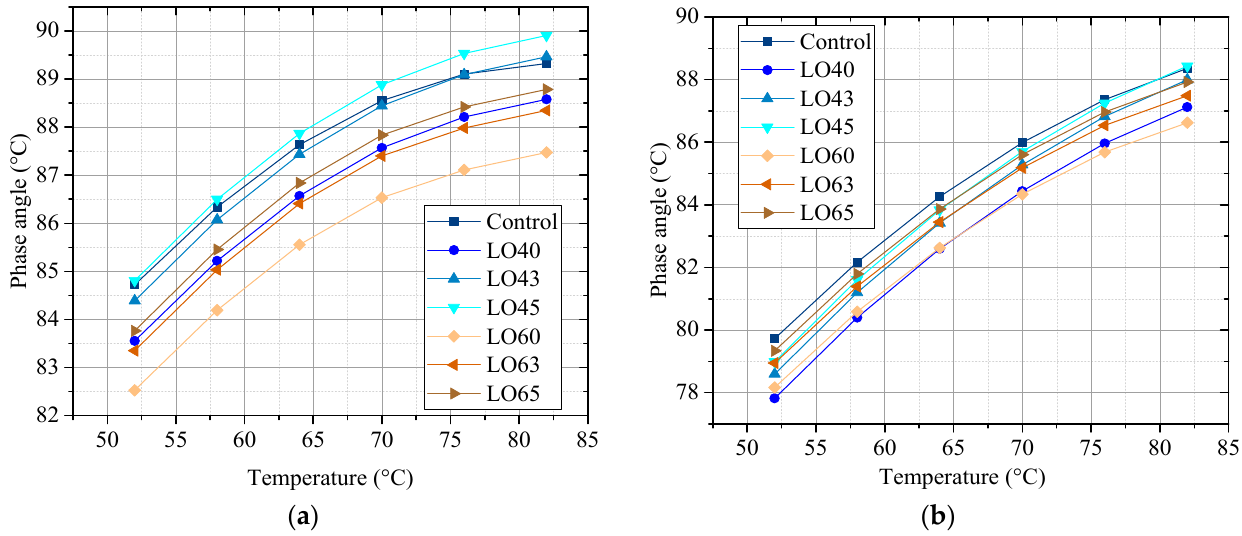
Figure 3. The viscosity of different asphalt types at 110 °C.